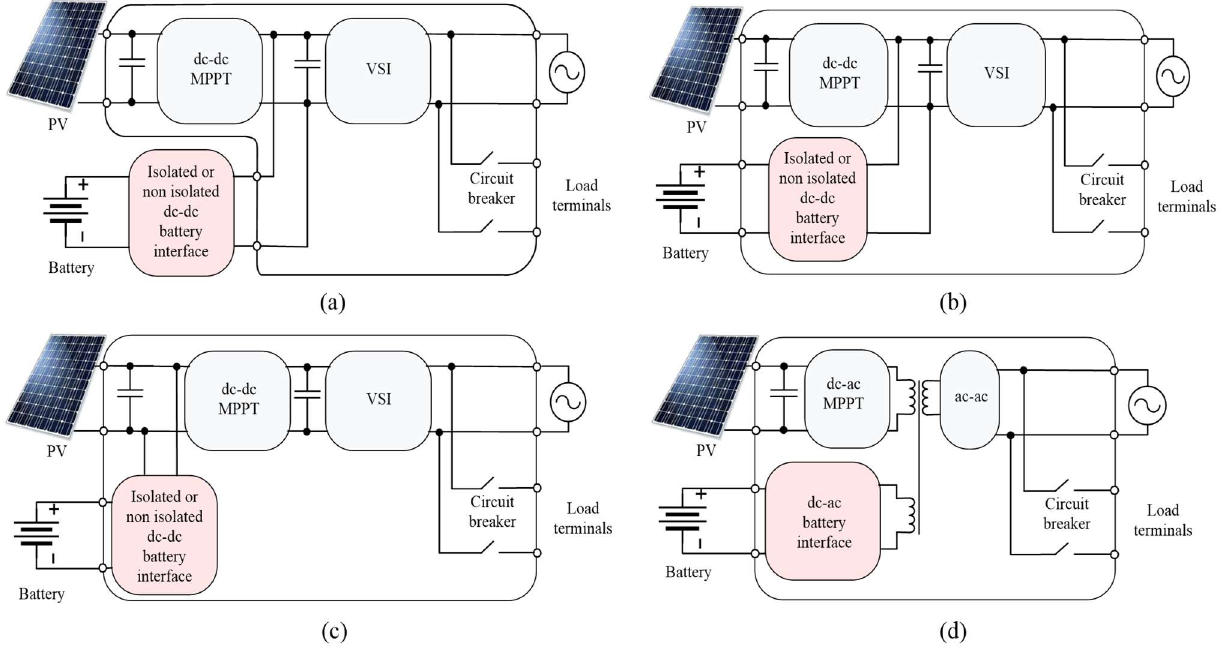
Figure 5. Typical structures of hybrid solar inverters. The battery connected directly to the dc-link ( a ), The battery integrated into the Energy Storage Systems and connected to dc-link (ESS) ( b ), the integrated battery interface connected to the dc low voltage ( c ), the integrated battery interface connected to the ac voltage ( d